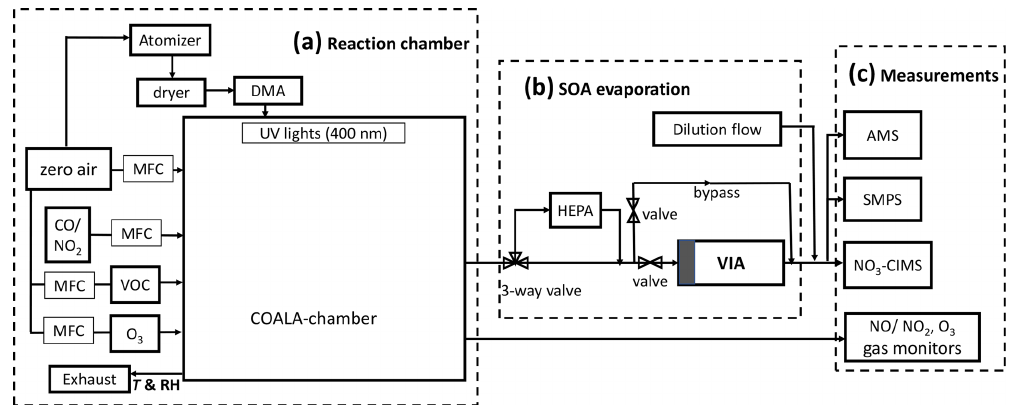
Figure 1. Setup for the thermal evaporation experiments used in this work. Note that all three parts (a–c) are necessary for the particle- phase HOM measurements, whereas only the parts in panels (a) and (c) are used for the gas-phase HOM measurements (i.e., all instruments sampling directly from the chamber). Table 1. Experimental conditions for the COALA chamber experiments. The steady-state conditions refer to the stabilized concentrations before adding seed particles. Input flow (in) conditions Steady-state (ss) conditions